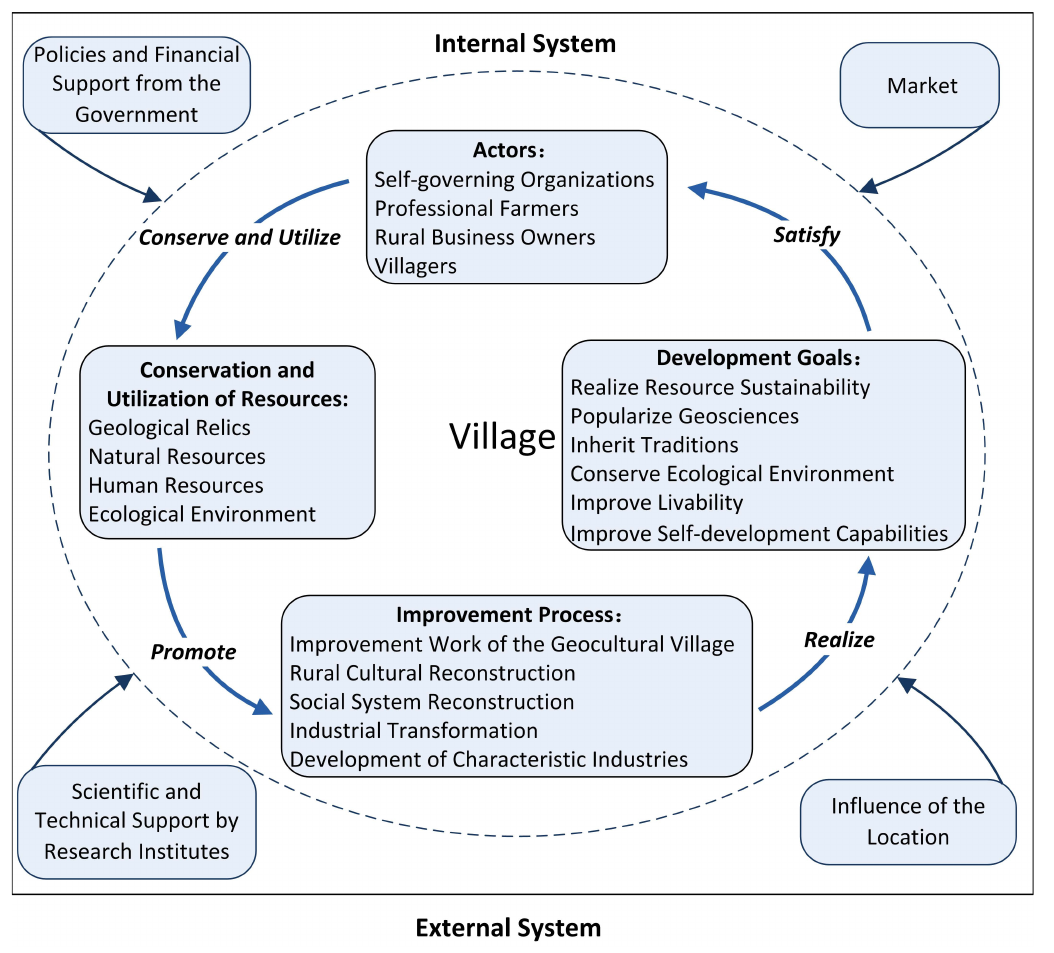
Scheme 1. The endogenous development mechanism of Baiyankeng geocultural